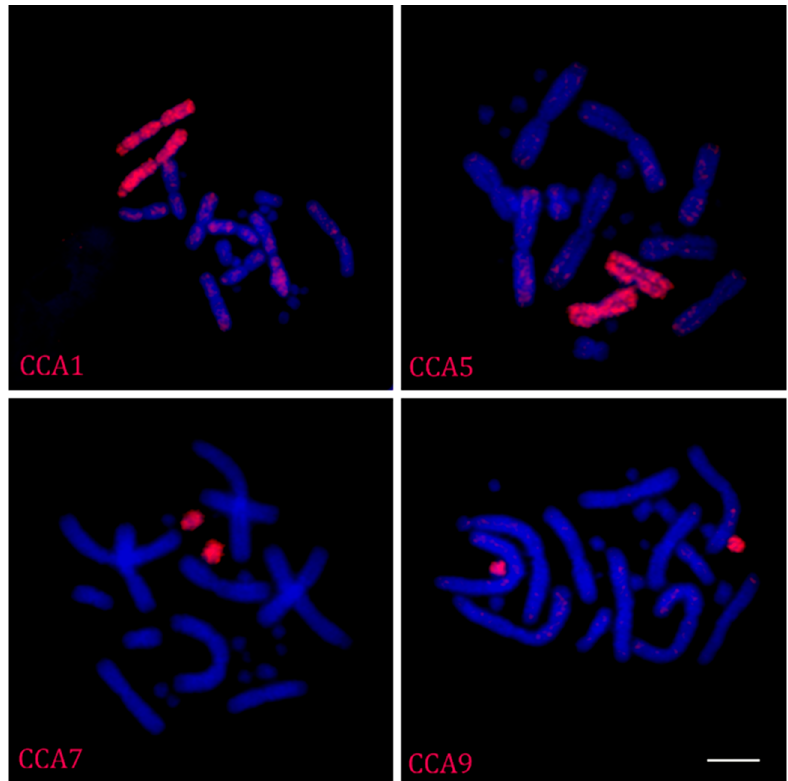
Figure 2. Examples of fluorescent in situ hybridization with the flow-sorted chromosome-specific probes of the C. calyptratus on metaphase plates of the same species. Scale bar = 10 µm. Only one probe labeled two microchromosomes (CCA10 and CCA11), as those were co-sorted to the same peak due to the similar sizes and GC content of these microchromo- somes.